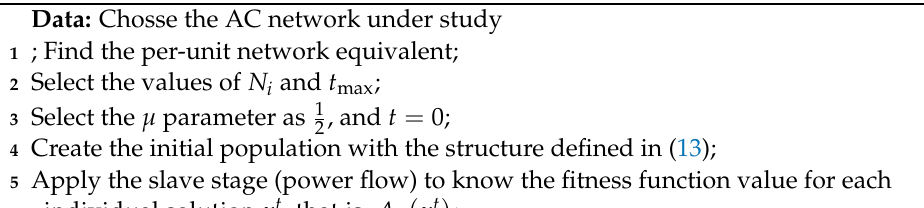
Algorithm 1: General application of the GNDO approach to select nodes and define sizes for D-STATCOMs in distribution